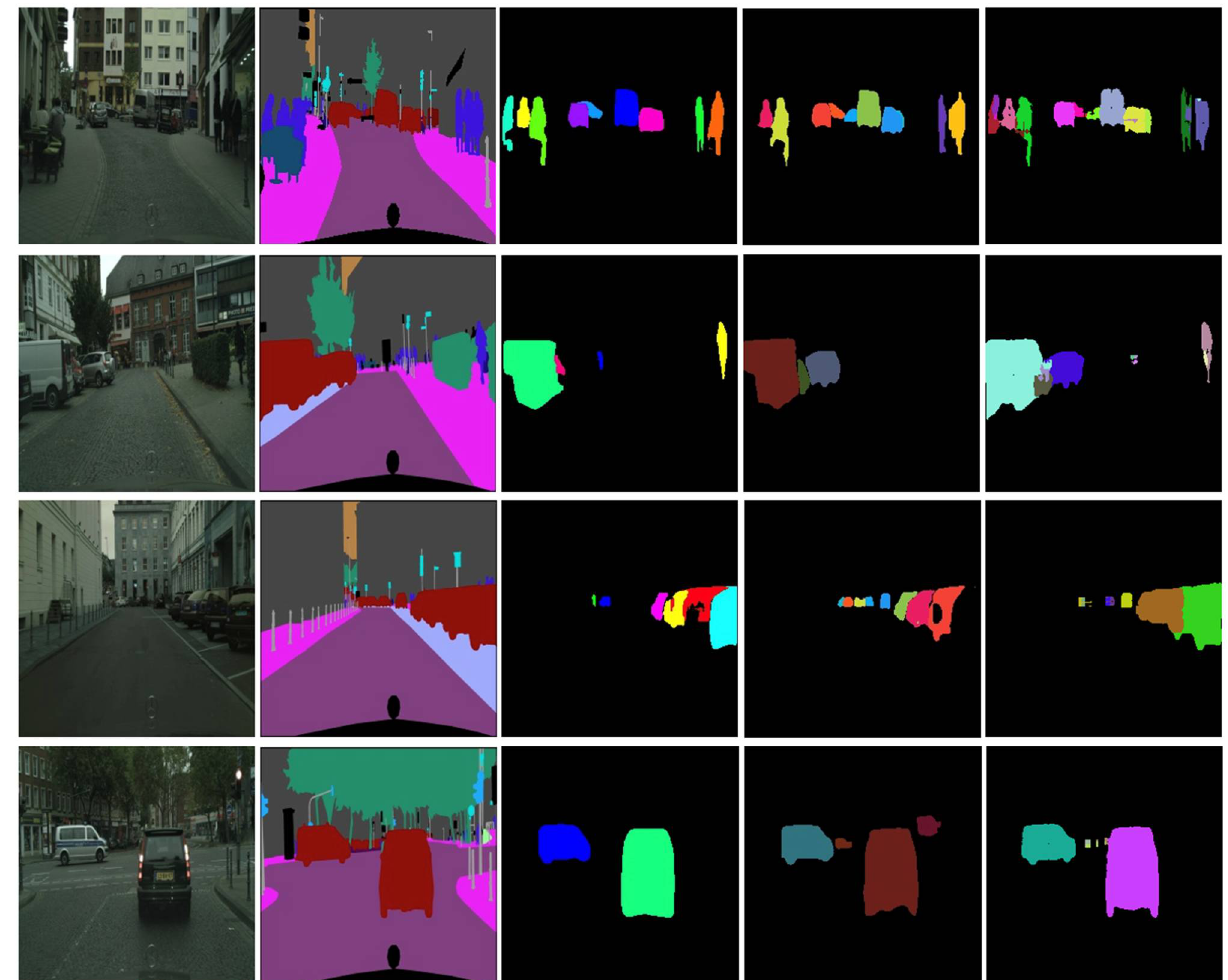
Figure 16. Comparison between Mask R-CNN, Yolact, and our method: the first column represents the input image, the second column shows the ground truth instances, the third column shows the Mask R-CNN results, the fourth column shows the Yolact results, and the fifth column represents our results.